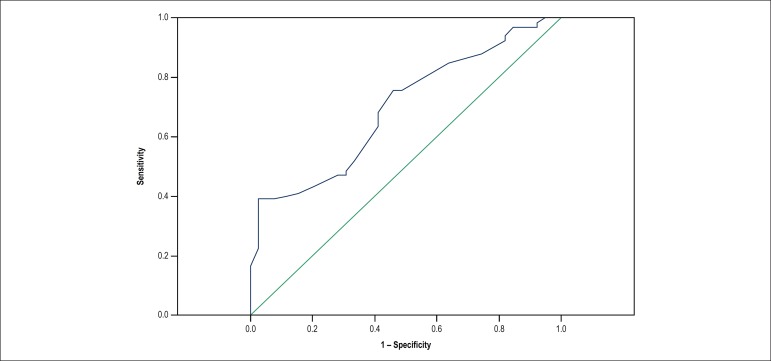
Receiver operating characteristic curve of heart rate in the supine
position (blue line), considering the stable variable postural
response without orthostatic hypotension.